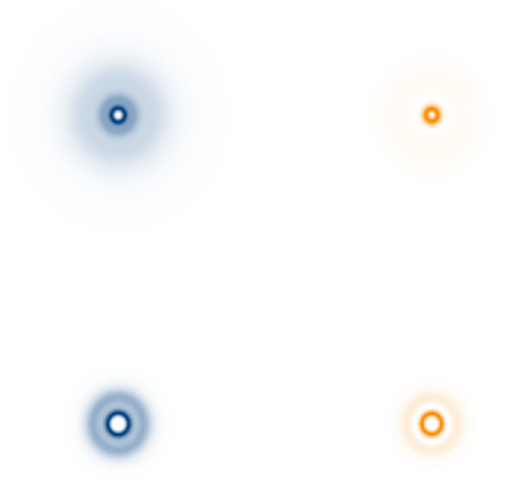
Fig. 10 The radial component of the electric field (left, blue) with e = 1 and the energy density (right, orange) associated to the model in Sect. 4.1.1 depicted in the plane for σ = 5 and α = 2, with k = 1 (top), and k = 2 (bottom). The intensity of the blue and orange colors increases with the increasing of the electric field and energy density, respectively